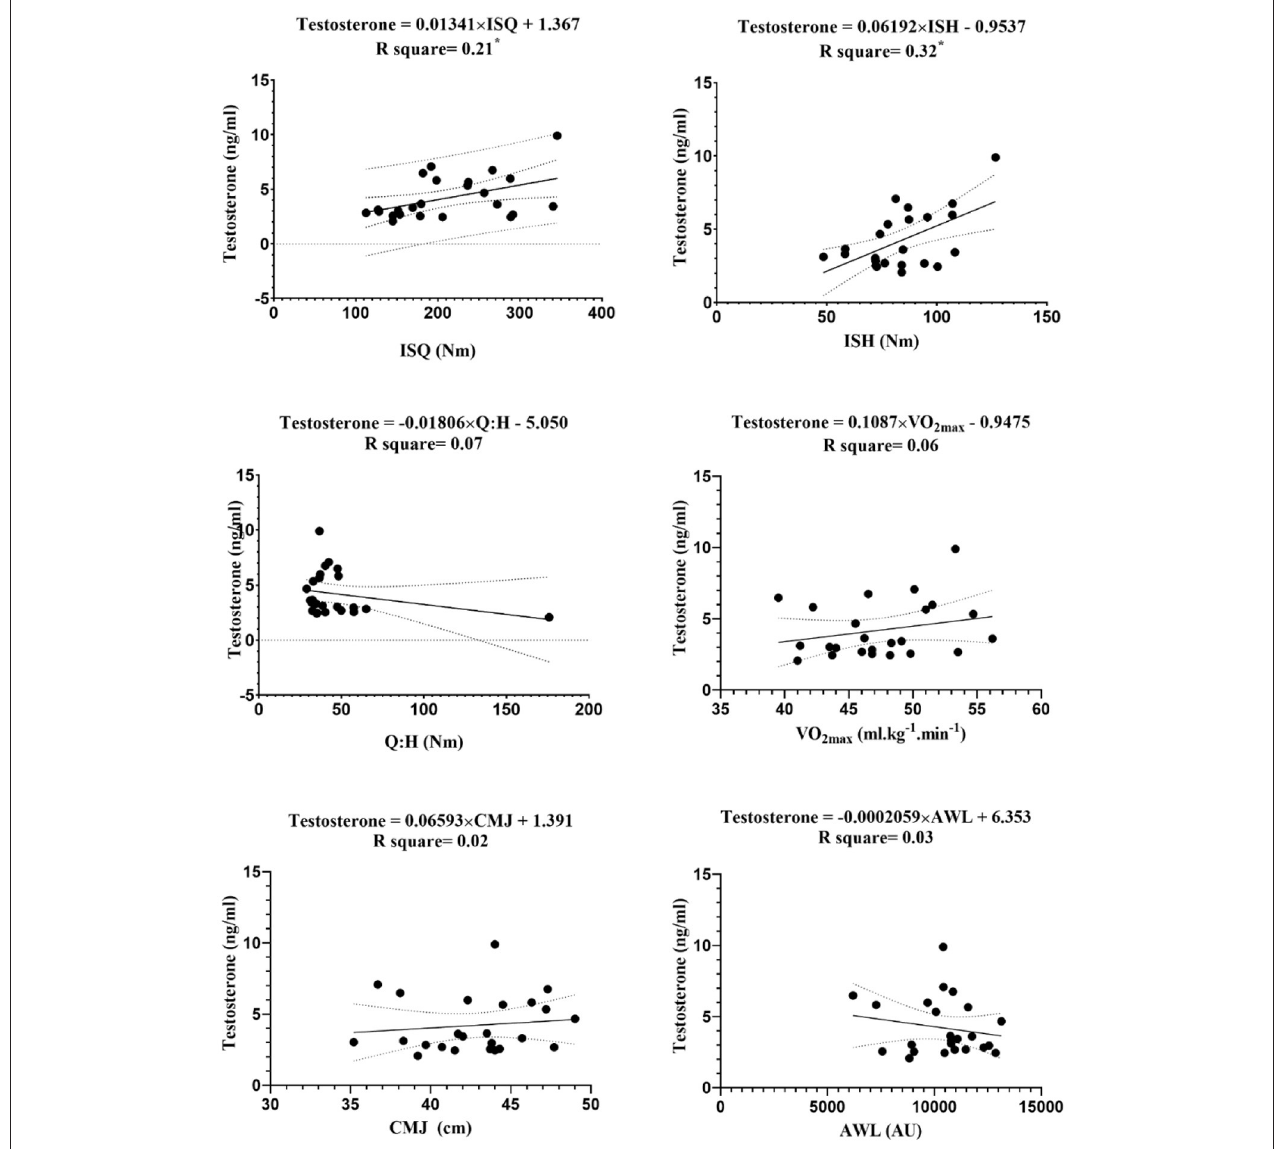
FIGURE 6 | Regression analysis to explain fitness levels and AWL (the average of the three stages) with testosterone; ISH, isometric muscular strength of the hamstring muscles; ISQ, isometric muscular strength of the quadriceps muscles; H:Q, the strength of isometric quadriceps to hamstring ratio; VO 2max , maximal oxygen uptake; CMJ, countermovement jump; AWL, accumulated workload training; Nm, Newton meter; AU, arbitrary unit. * Significant differences p ≤